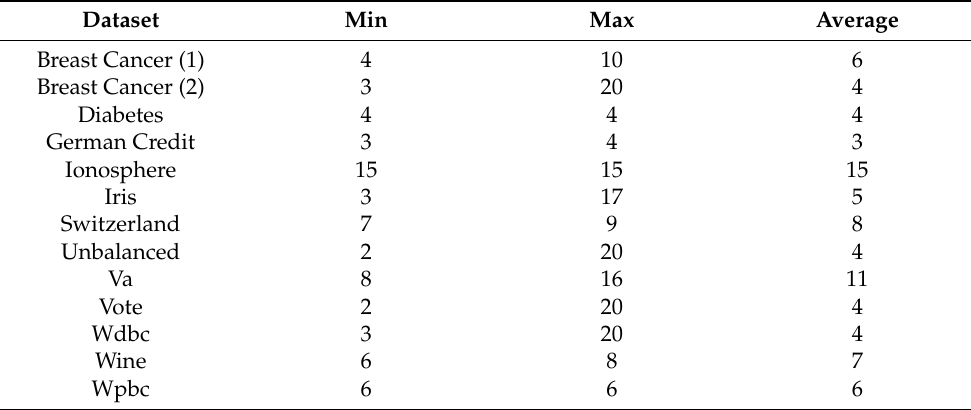
Table 1. Number of automatically generated layers at the end of